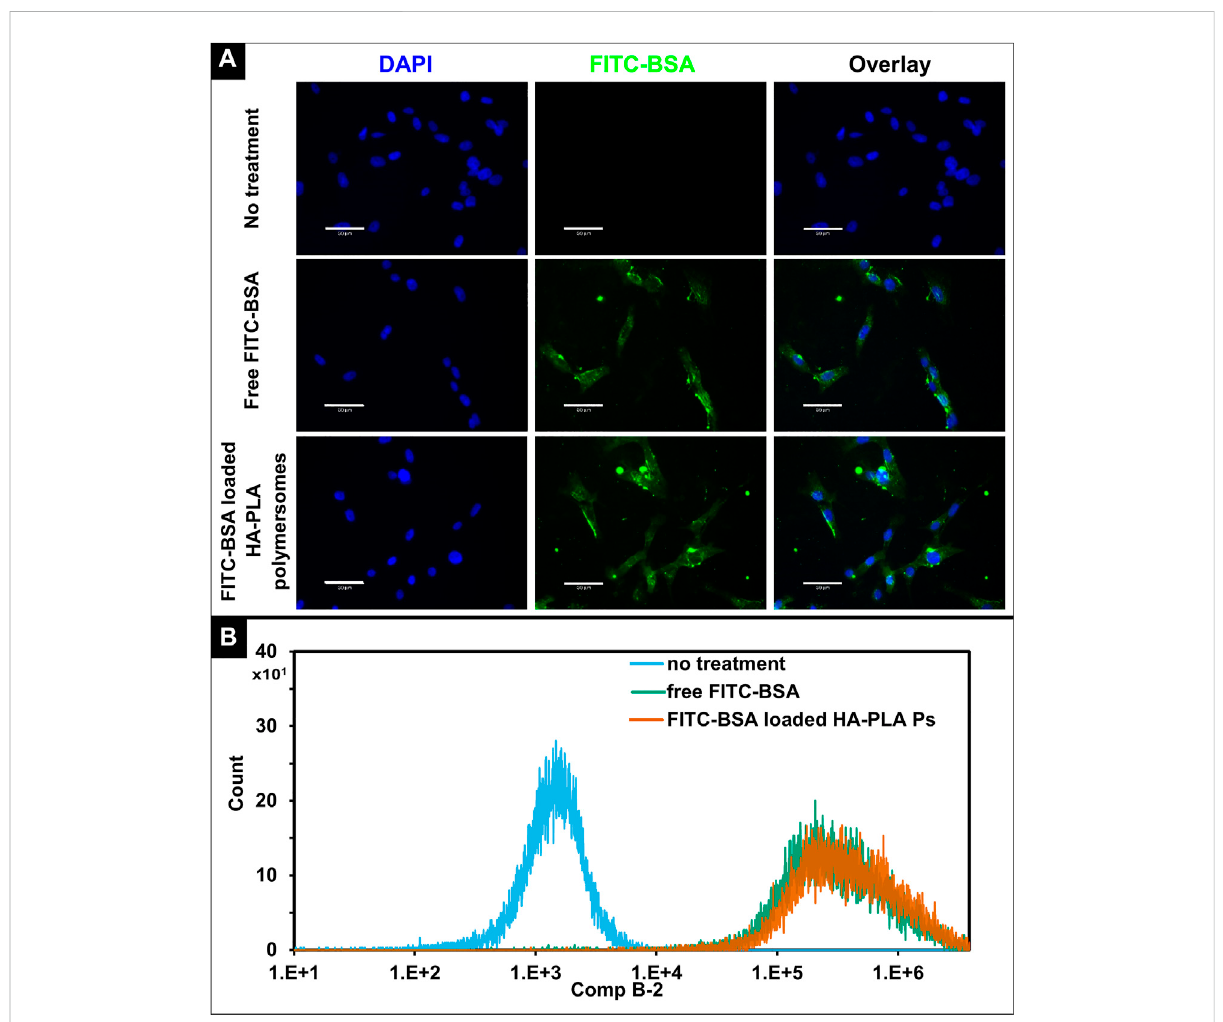
FIGURE 6 In vitro cellular uptake of Hyaluronic acid-polylactic acid (HA-PLA) polymersomes. (A) Fluorescent images of GM1SV3 cells without treatment, after treating with free albumin- fl uorescein isothiocyanate conjugate (FITC-BSA) and FITC-BSA loaded HA-PLA polymersomes, (B) Flow cytometry histograms for unstained GM1SV3 cells, GM1SV3 cells treated with free FITC-BSA, and FITC-BSA loaded HA-PLA polymersomes ( n = 3). (Scale bar = 60 μ